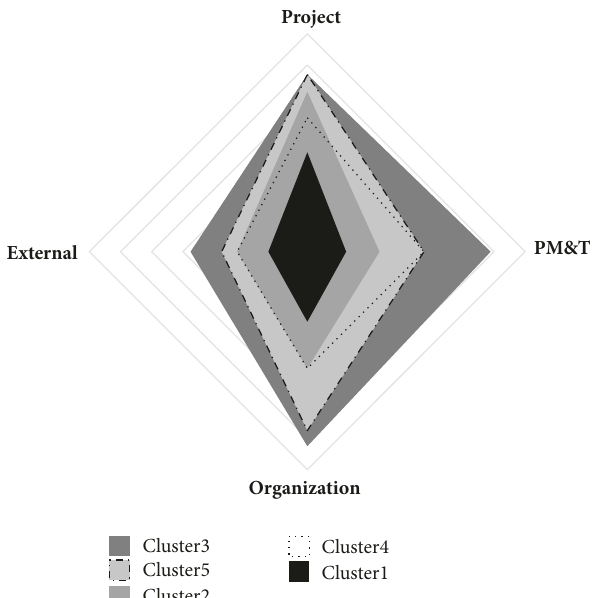
Figure 12: Radar chart representing the average rate for the factors of each category.